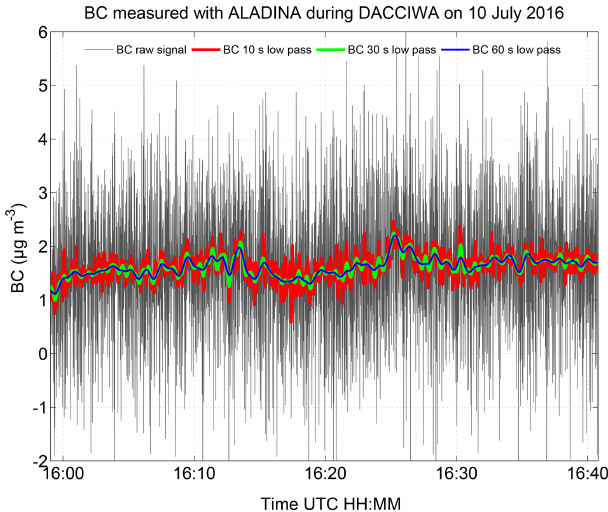
Figure 3. BC mass concentration measured during one flight be- tween 15:58 and 16:42UTC on 10 July 2016. The raw signal of BC (grey line) was phase-shift-free low-pass-filtered after post- processing with 10s (red line), 30s (green line), and 60s (blue line).